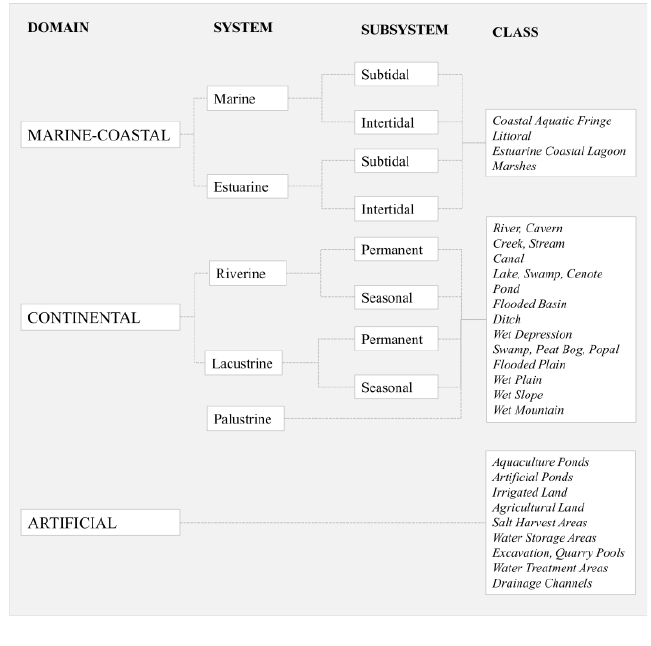
Figure 6. Mexican Wetland Classification System proposed by [111] (translation).